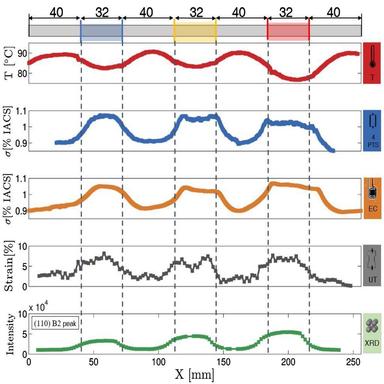
Overview of all techniques used for FGM characterization. From top to bottom: temperature variation by Joule heating effect, electrical conductivity by 4 point probe, electrical conductivity by eddy-current, local strains at maximum global strain (5 %) and intensity profile of B2 (110) peak by synchrotron XRD analysis.